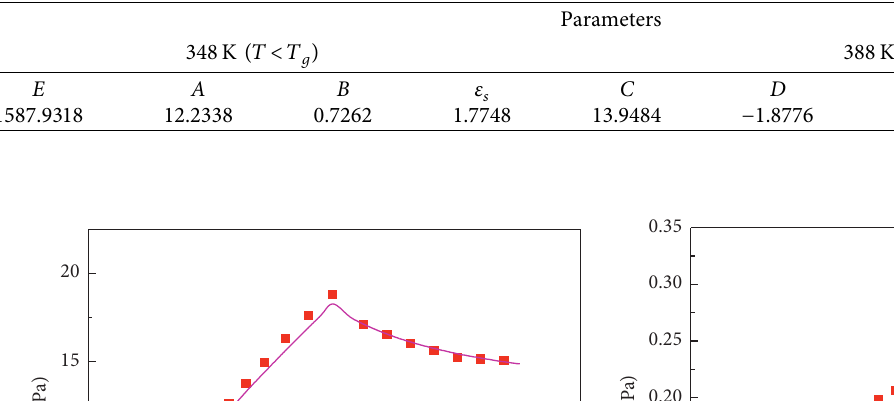
Figure 9: Fitting results of H and G at different temperatures. Table 4: Parameters of the model at 348K and 378K.